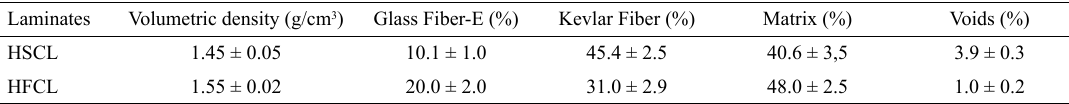
Figure 3. Thermogravimetry test: (a) HSCL; (b) HFCL. Table 1. Volumetric density and volume fraction of reinforcement, resin and voids.